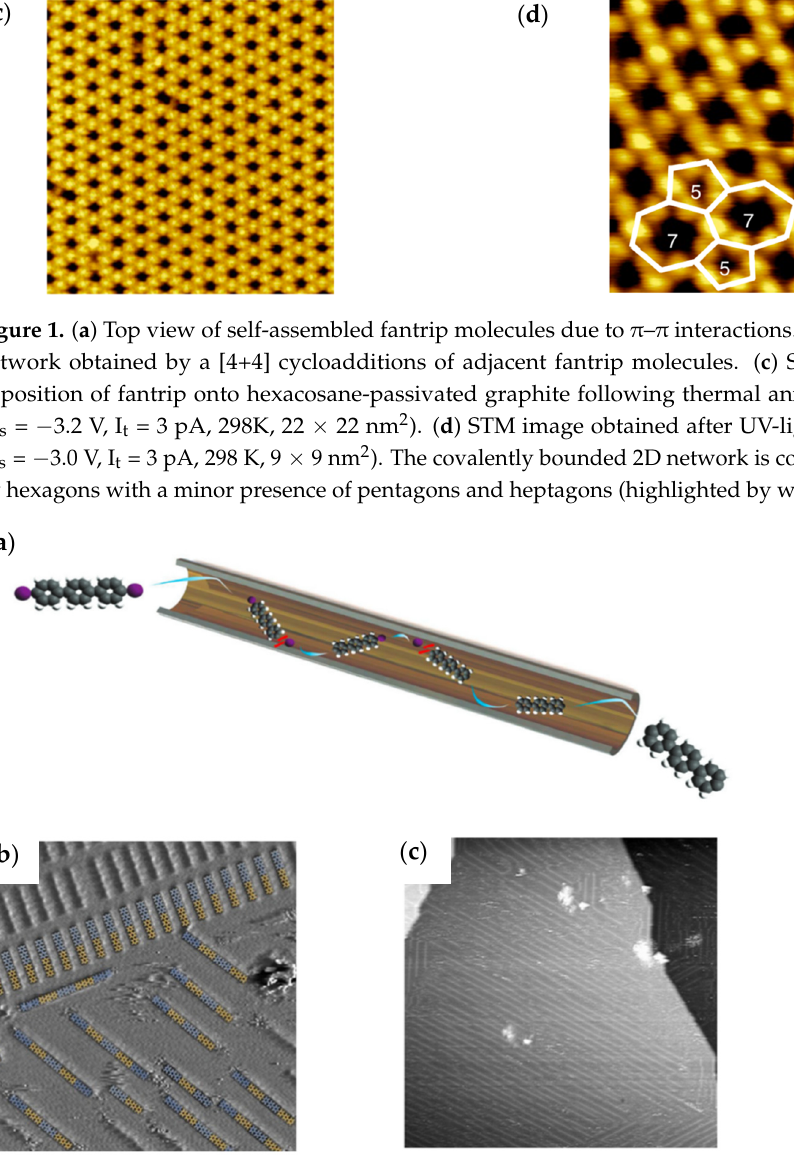
Figure 2. ( a ) Scheme of principle of direct deposition of organic radicals by activation during the time-of-flight of iodinated precursors passing through a gold-plated stainless steel drift tube. ( b ) STM image after deposition of triphenyl diradicals and thermal annealing at 375 K (V s = − 0.96 V, I t = 104 pA, 5 K, 30 × 30 nm 2 ) onto Au(111)-I surface. ( c ) STM image after deposition of triphenyl diradicals and thermal annealing at 425 K (V s = − 1.19 V, I t = 84 pA, 5 K, 100 × 100 nm 2 ).